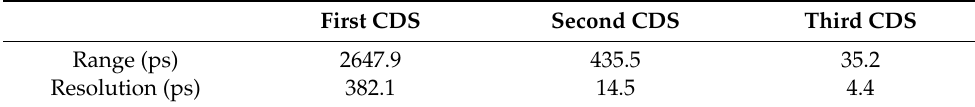
Table 2. The timing resolution and controllable range of each CDS.